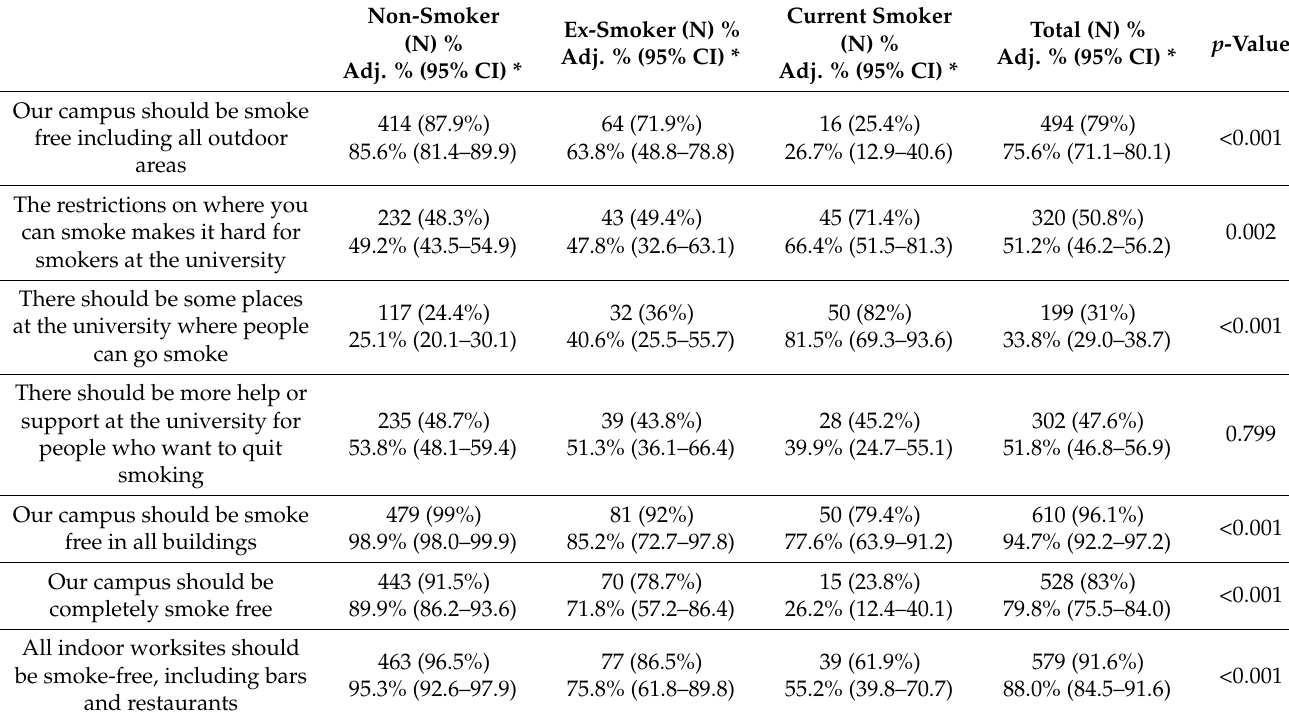
Table 3. Agreement with tobacco control attitude statement reported by university staff and